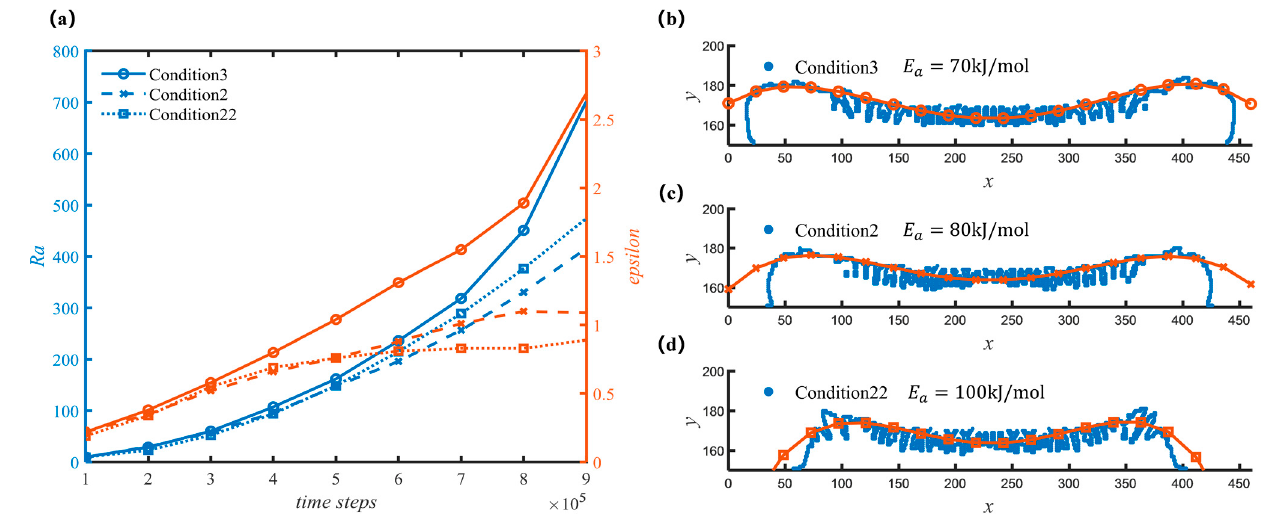
Figure 6. Morphology of sediments with different homogeneous reaction activation energy. ( a ) Curves of roughness and overall trend with different working conditions; ( b ) Sediment profile and fit line for condition 3 at 500,000 time steps; ( c ) Sediment profile and fit line for condition 2 at 500,000 time steps; ( d ) Sediment profile and fit line for condition 22 at 500,000 time